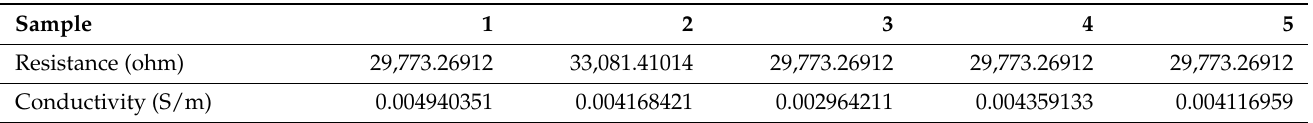
Table A20. Conductivity Data for Nylon 610 Nanocomposites with 4.5 wt% Untreated Graphite